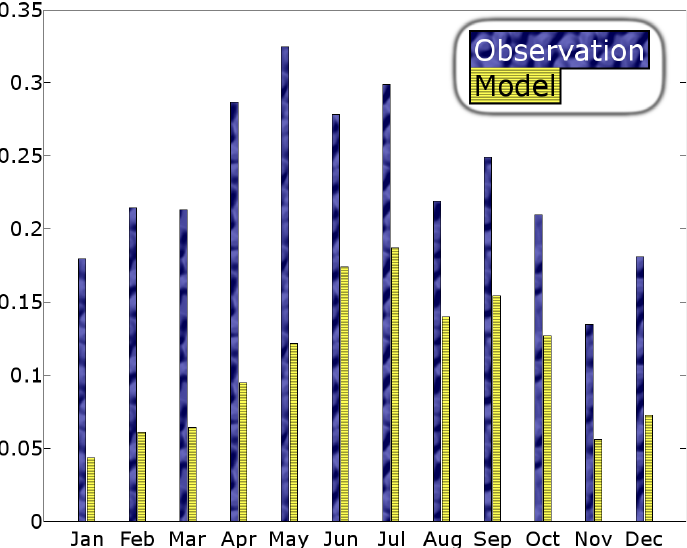
Fig. 9. Comparison between modelled and observed AOD per month. Valid data of all AERONET stations are